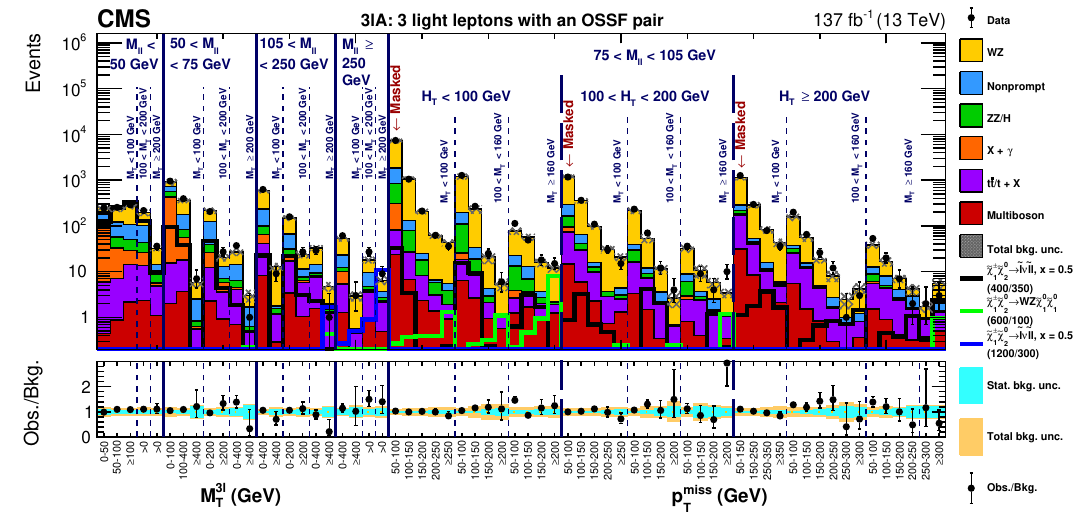
Figure 8 . Observed and expected yields across the search regions in events with three light leptons, at least two of which form an OSSF pair (3 ‘ A). Several signal models are shown superimposed. ± 0 They correspond to production with slepton-mediated decays in the flavor-democratic e c 2 1 e c hypothesis for a compressed δm = 50 GeV (black line) and uncompressed δm = 900 GeV (blue line) scenario, and for WZ -mediated decays in an uncompressed δm = 500 GeV scenario (green line). Bins labeled as “Masked” are not considered in the interpretation of the results because of overlap with the WZ control region. The legends specify the masses of signal distributions as ( m / m 0 0 e c e c 2 1